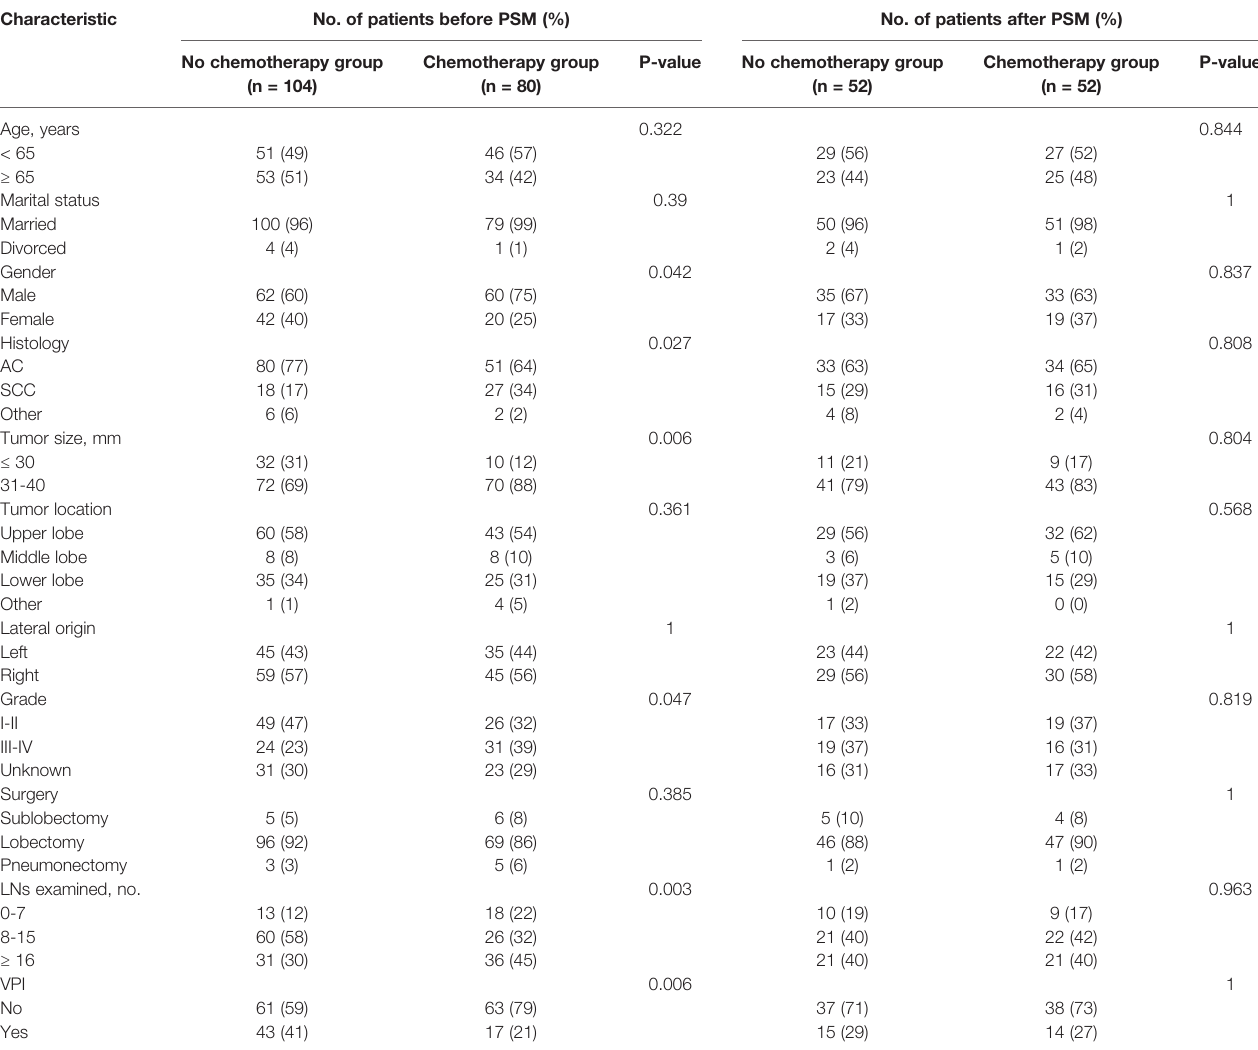
TABLE 3 | Baseline characteristics of stage IB NSCLC patients in the validation cohort.